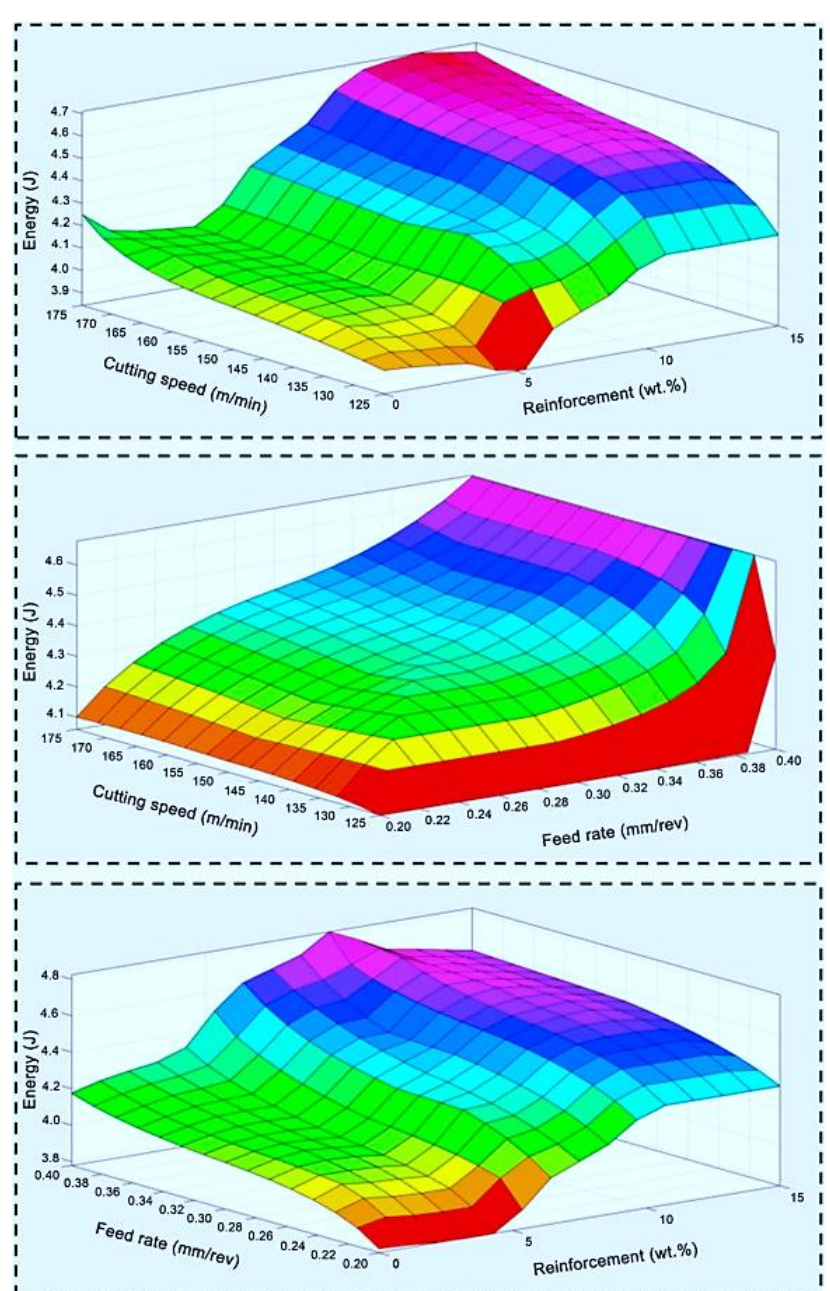
Figure 12. Influence of machining parameters on consumption of energy [145].